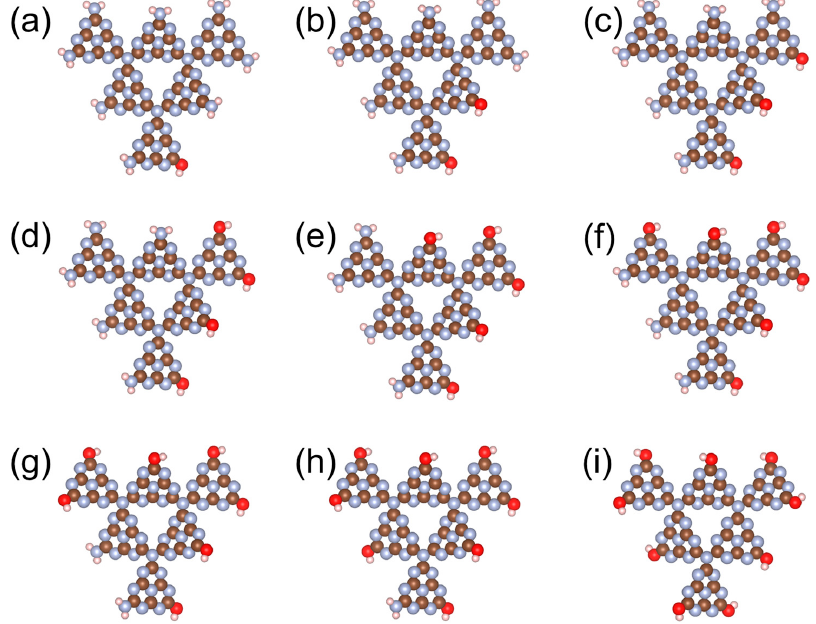
Figure 5. Structures of g-C 3 N 4 -6 with varying numbers of O − H groups. Brown, blue, pink, and red spheres represent C, N, H, and O, respectively.